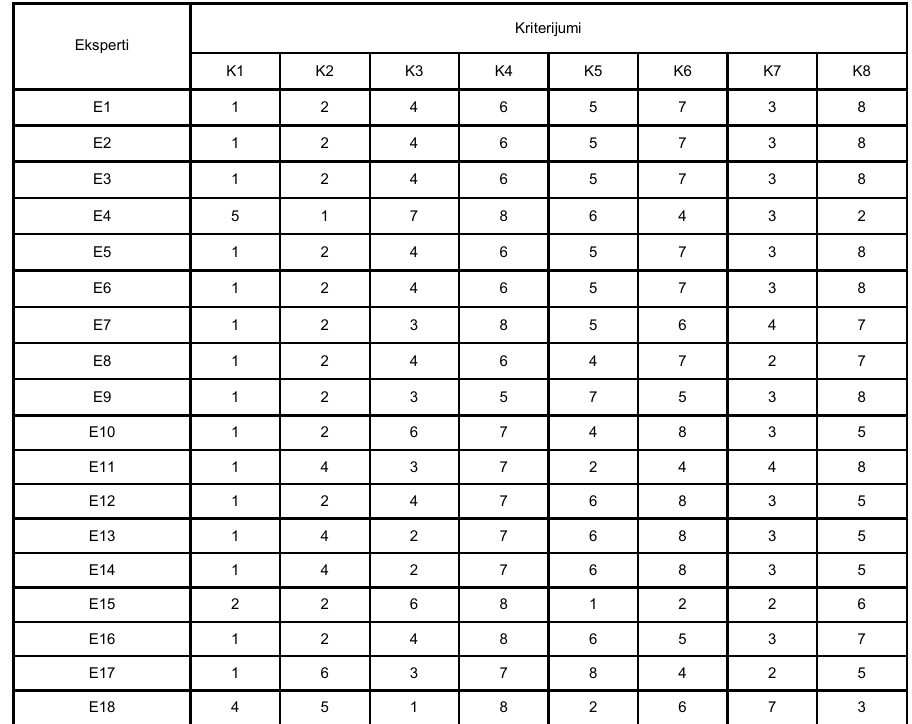
Tabela 1 – Rezultati rangiranja Table 1 – Ranking